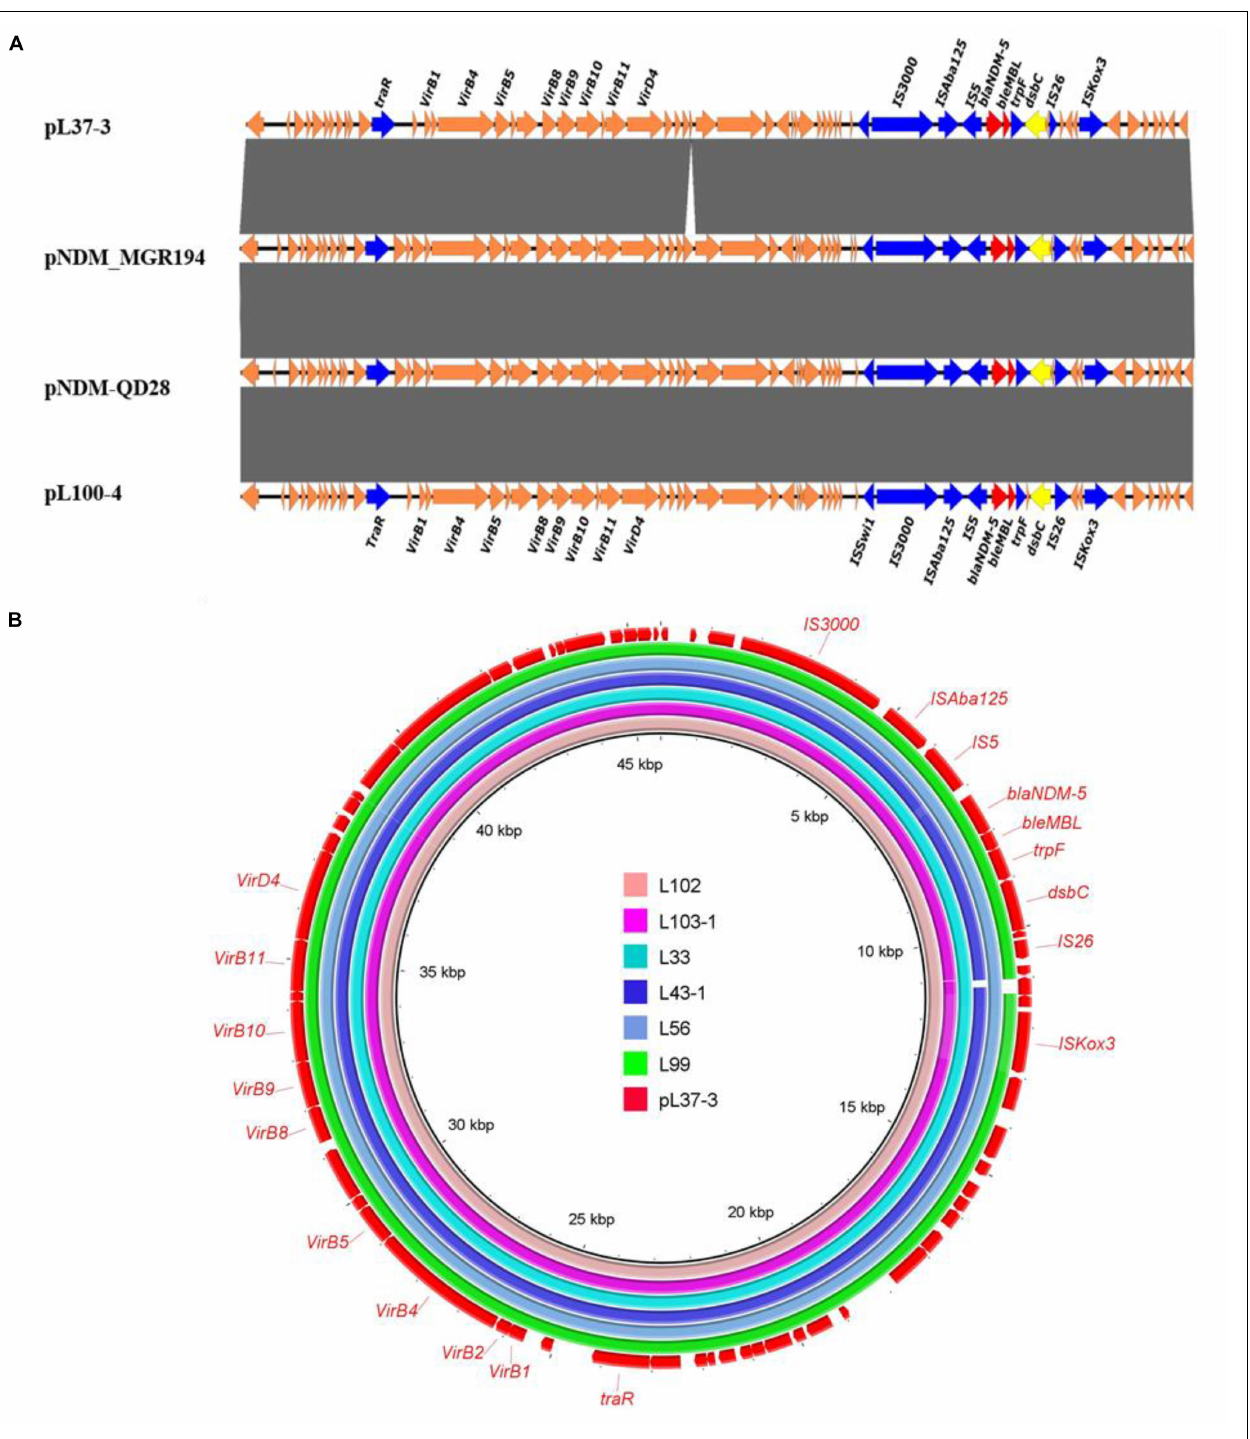
FIGURE 1 | Sequence alignment analysis of IncX3 bla NDM − 5 plasmids. (A) Linear alignment of four bla NDM − 5 -bearing E. coli strains. pNDM-QD28 (GenBank accession no. KU167608.1) and pNDM_MGR194- bla NDM − 5 (GenBank accession KF220657.1) were the reported bla NDM − 5 -bearing plasmids. Plasmids pL41-1-4, pL53-4, pL65-9 and pL103-2-5 shown identical structure with pL100-4. (B) Circular comparison between the bla NDM − 5 -bearing IncX3 plasmid pL37-3 and the assembled contigs of other six bla NDM − 5 positive strains without MinION data and based on Illumina data.